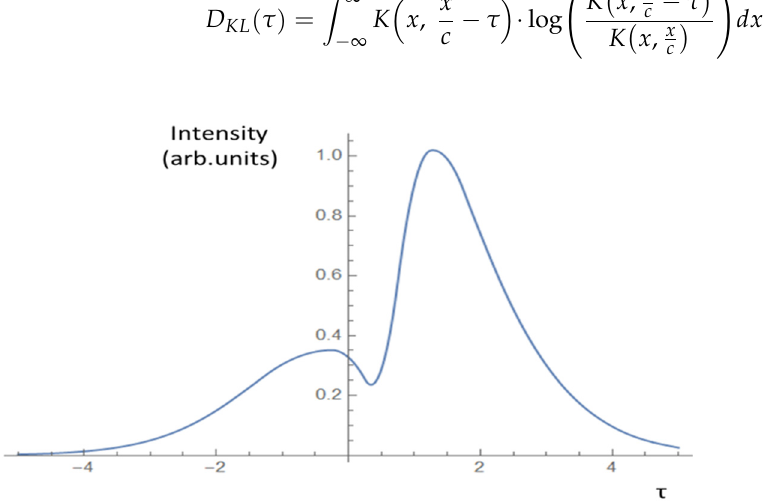
(cid:82) 10 − τ ) dx (see K 2 ( x , x − (cid:2028))(cid:1856)(cid:1876) (see − 10 v (cid:2879)(cid:2869)(cid:2868)